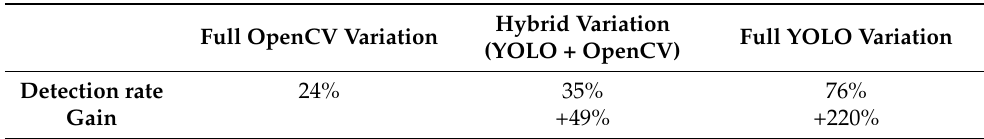
Table 1. Detection rate obtained over the calibration images in our database by the three pipeline variations. The gain is compared to the Full OpenCV